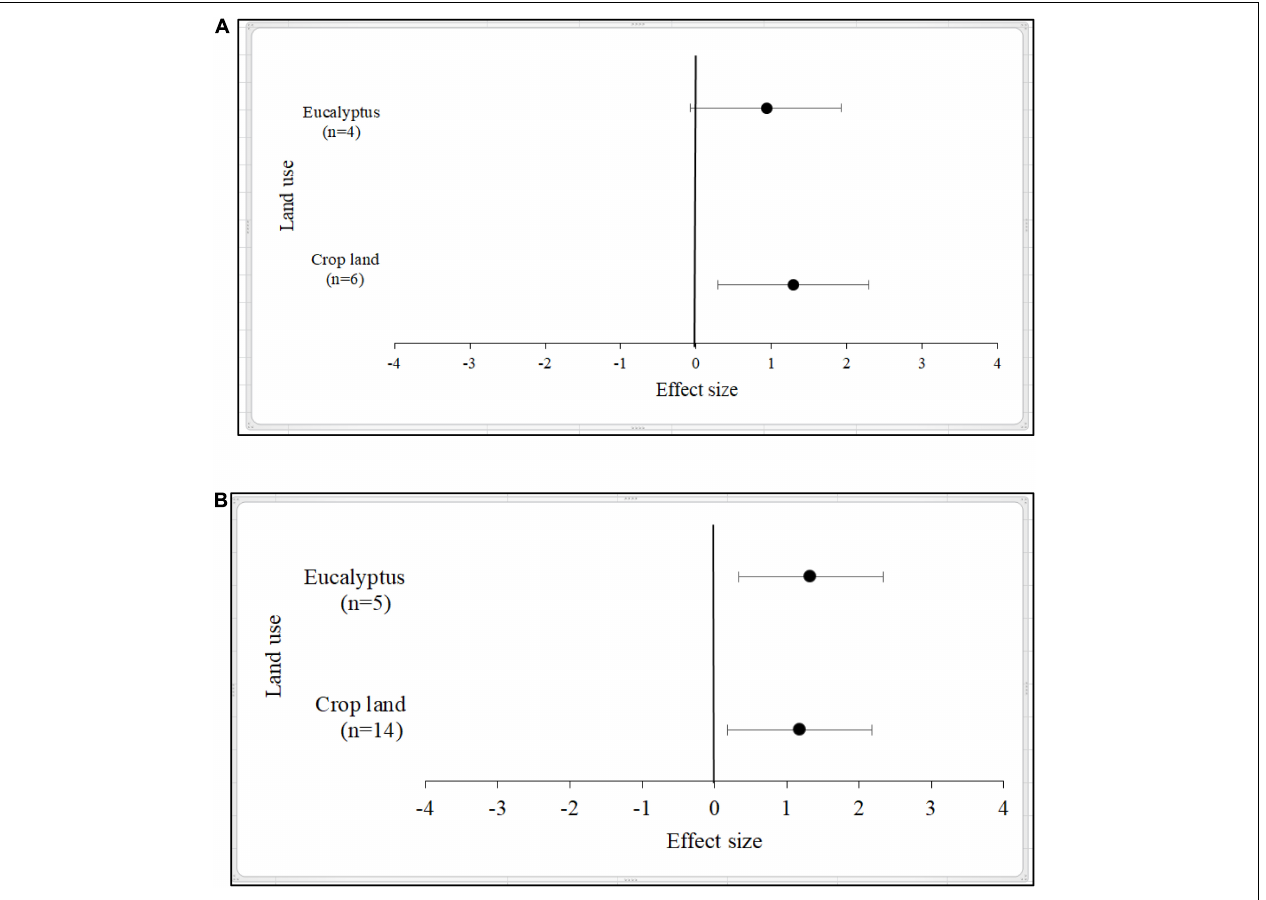
FIGURE 10 | Differences in soil organic carbon (A) and total soil nitrogen (B) among exclosures, cropland, and eucalyptus plantation. See Figure 5 for further